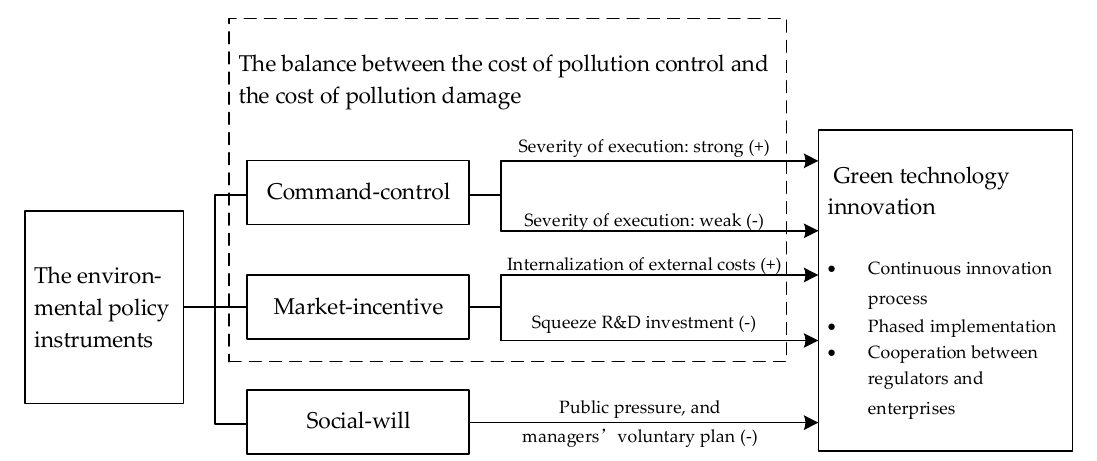
Figure 1. Influence mechanism of different types of environmental policy instruments on green technology innovation.